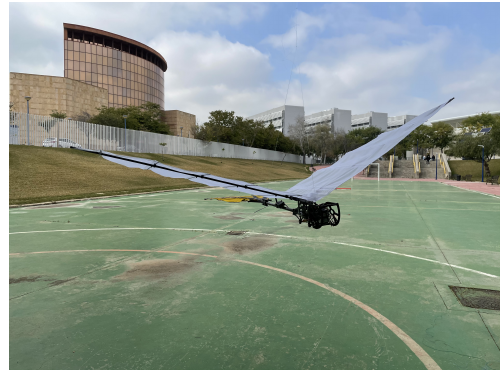
Figure 16. Outdoor Setup.